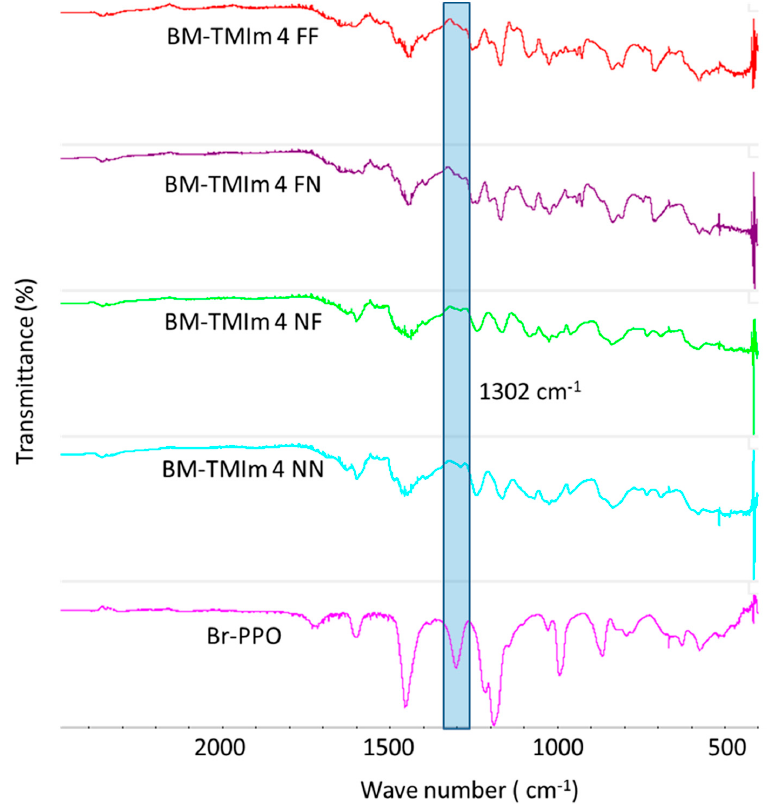
Figure 3. FT-IR spectrum of anion exchange blend membranes and Br-PPO.